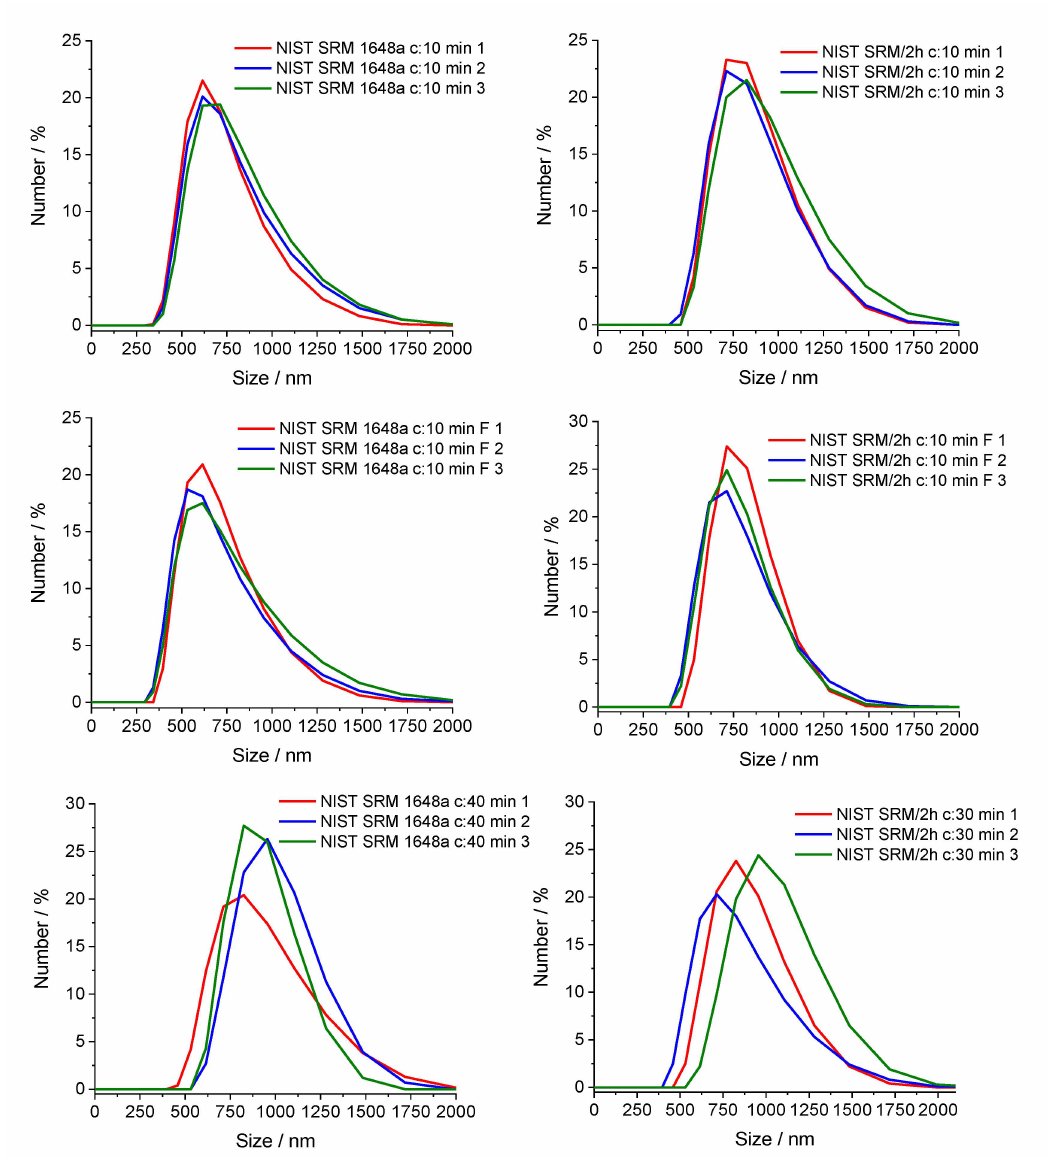
Figure 7. The particle size of NIST SRM 1648a and SRM/2 h prepared in different methods (C10, C30, C40—centrifugation time in minutes, F—filtration). Each sample has been analyzed in